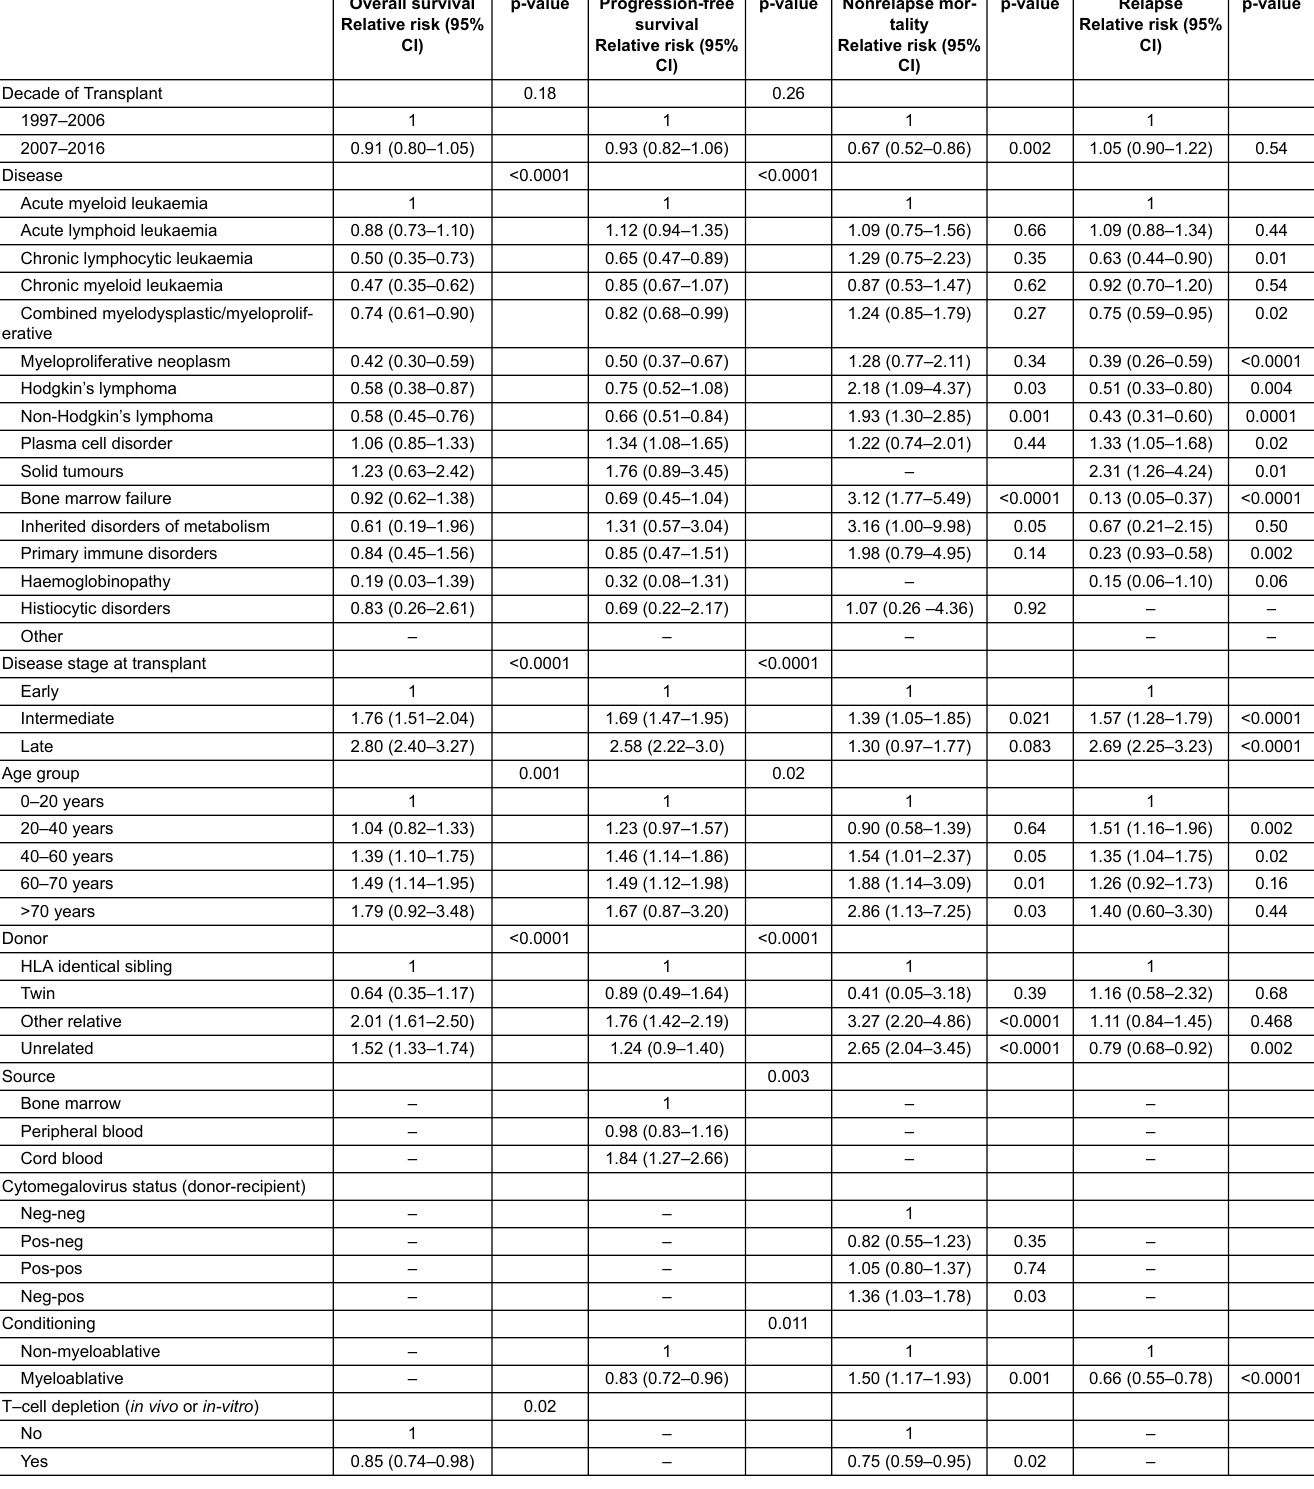
Table 3a:: Multivariate analysis of survival, progression free survival, nonrelapse mortality and relapse for allogeneic haematopoietic cell transplants for the years 1997–2016. Overall survival p-value Progression-free Relative risk (95% CI)